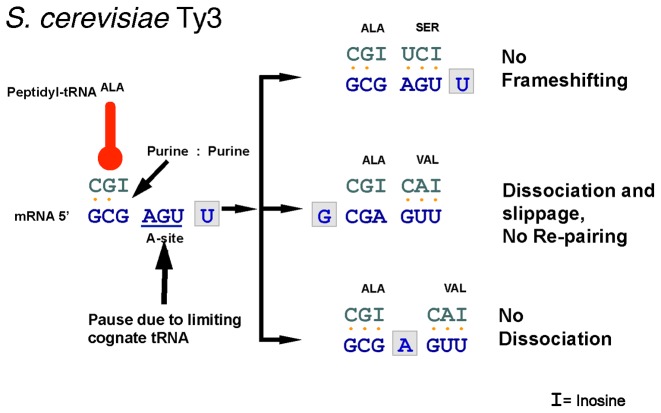
Absence (or minimal) potential for re-pairing to mRNA at an overlapping +1 frame codon in S. cerevisiae Ty3 frameshifting. Biophysical studies are needed to determine whether the tRNAAla anticodon 3′GCI5′ (where I is inosine) dissociates at the time of frameshifting. Only a small number of codons can substitute for GCG, including CGA (422). See text and (453, 814) for discussion of this and other candidate occurrences.